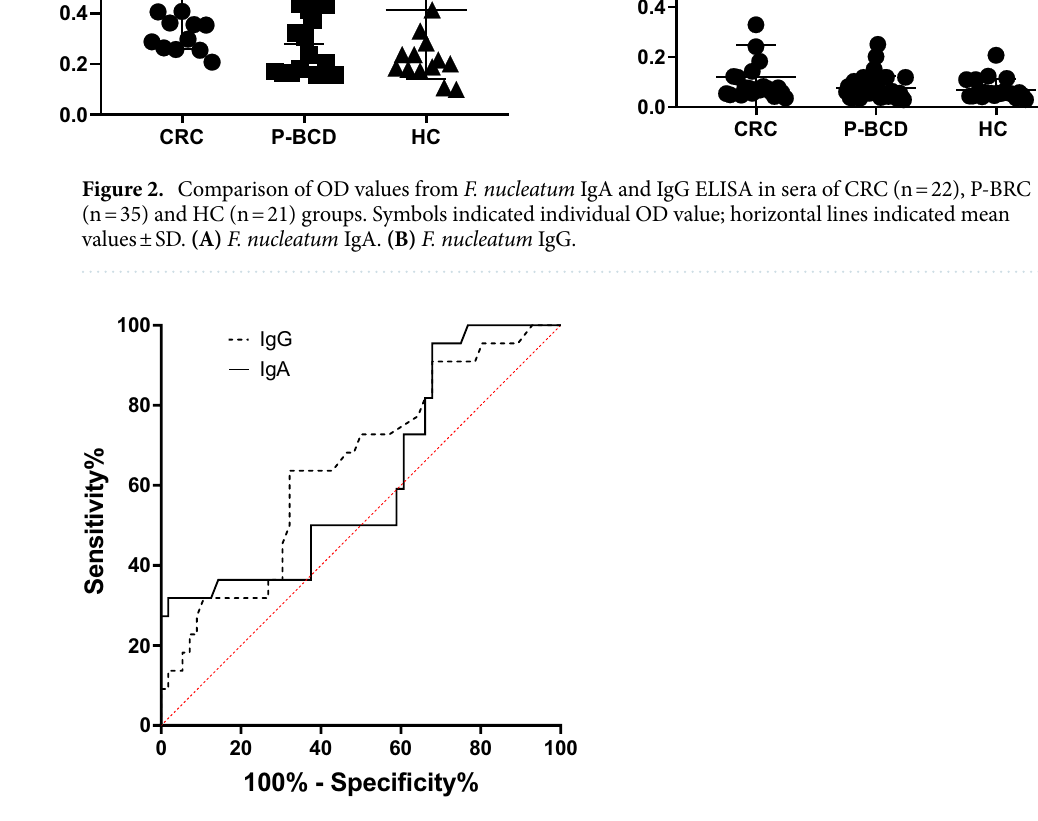
Figure 3. ROC curve for F. nucleatum IgA and IgG ELISA tests using serum from colorectal cancer patients and healthy controls. The reference tests were colonoscopic examination and pathological evaluation of biopsy material. IgA AUC = 0.6185, IgG AUC =